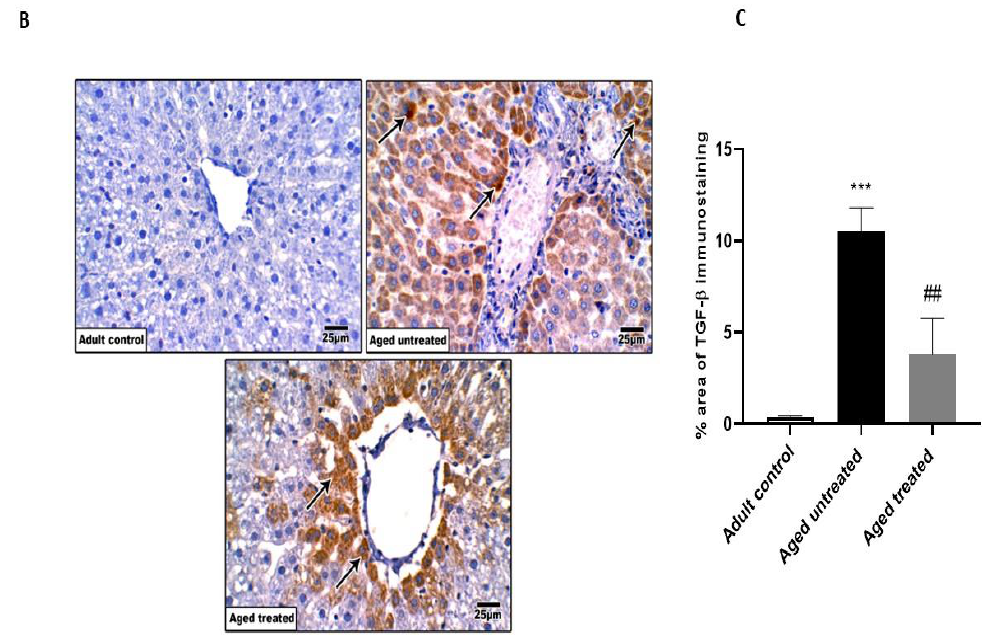
Figure 6. Effect of VK2 administration on markers of fibrosis in hepatic tissue. ( A ) Hepatic tissue inhibitor of metalloproteinase (TIMP) concentration (ng/mg protein), ( B ) hepatic TGF- β immunostaining and ( C ) quantitative assessment of the % area of hepatic TGF- β immunostaining. Values are expressed as the mean ± SE, n = 6. *** p < 0.001 compared to the Adult control group. ## p < 0.01 and ### p < 0.001 compared to the Aged untreated group.